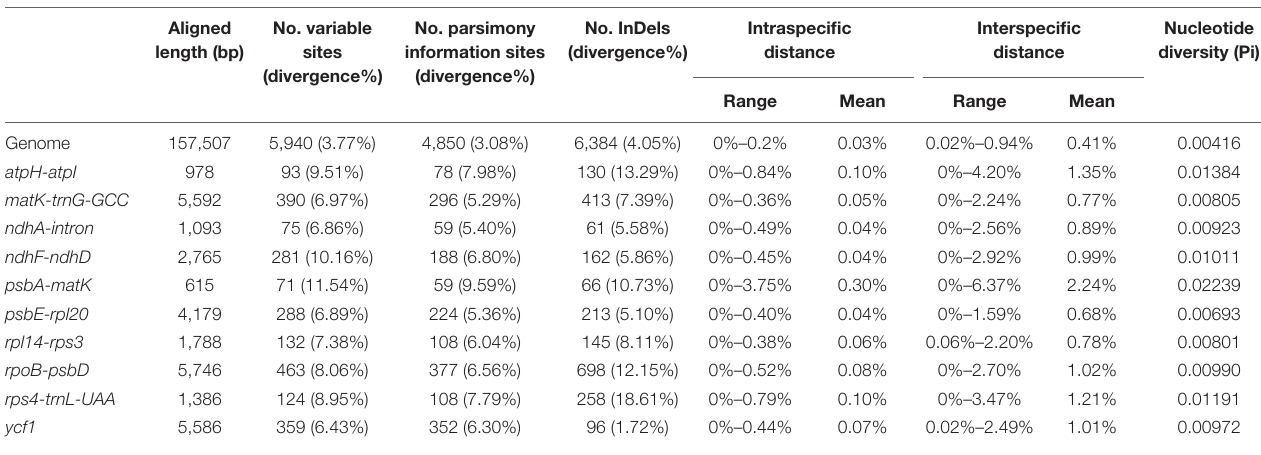
TABLE 2 | Characteristics of the complete plastome and high variable regions in Fritillaria